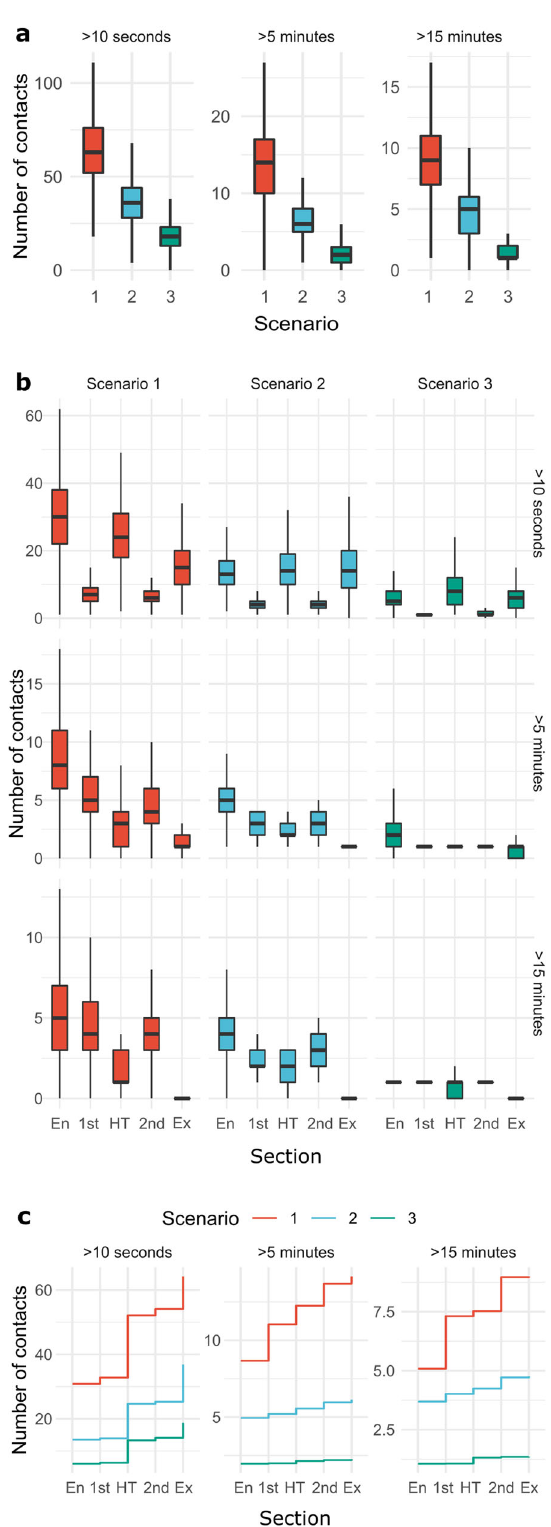
Fig. 1 Number of contacts in Scenario 1 (red), 2 (blue), and 3 (green). a Number of contacts by duration (>10 s, >5 min, >15 min) over all settings, b for the different sections: Entry (En), 1 st half (1 st ), half time (HT), 2 nd half (2 nd ), exit (Ex) and c cumulatively throughout the different settings. The center line represents the median, the box limits the upper and lower quartiles and whiskers extend from the hinge to the smallest/largest value no further than 1.5 * IQR from the hinge. n Scenario 1 = 1192 participants, n Scenario 2 = 1158 participants, n Scenario 3 = 1054 participants. See Supplementary Table 3 for components of the hygiene practices in the three